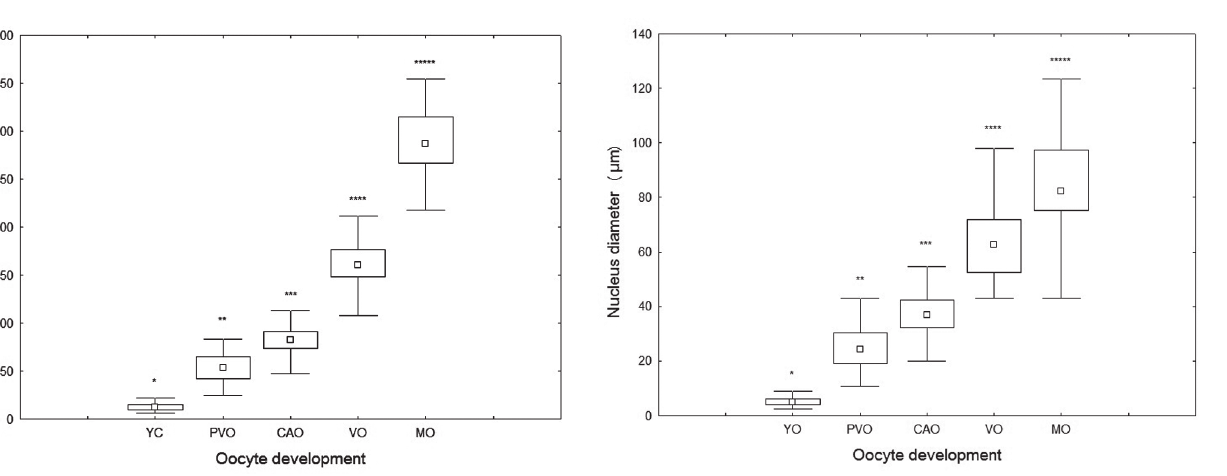
Fig. 4. Mean diameter ( μ m) of oocytes for each oocyte Fig. 5. Mean diameter (ìm) of nuclei of oocytes for each oocyte development stage of ovaries of black triggerfish caught in the São Pedro e São Paulo Archipelago, between January 2006 and May 2008. (YC) young cell, (PVO) pre-vitellogenic oocyte, (CAO) cortical alveoli oocytes, (VO) vitellogenic oocytes and (MO) mature oocytes. Asterisks indicate significant differences (Wilcoxon, p <